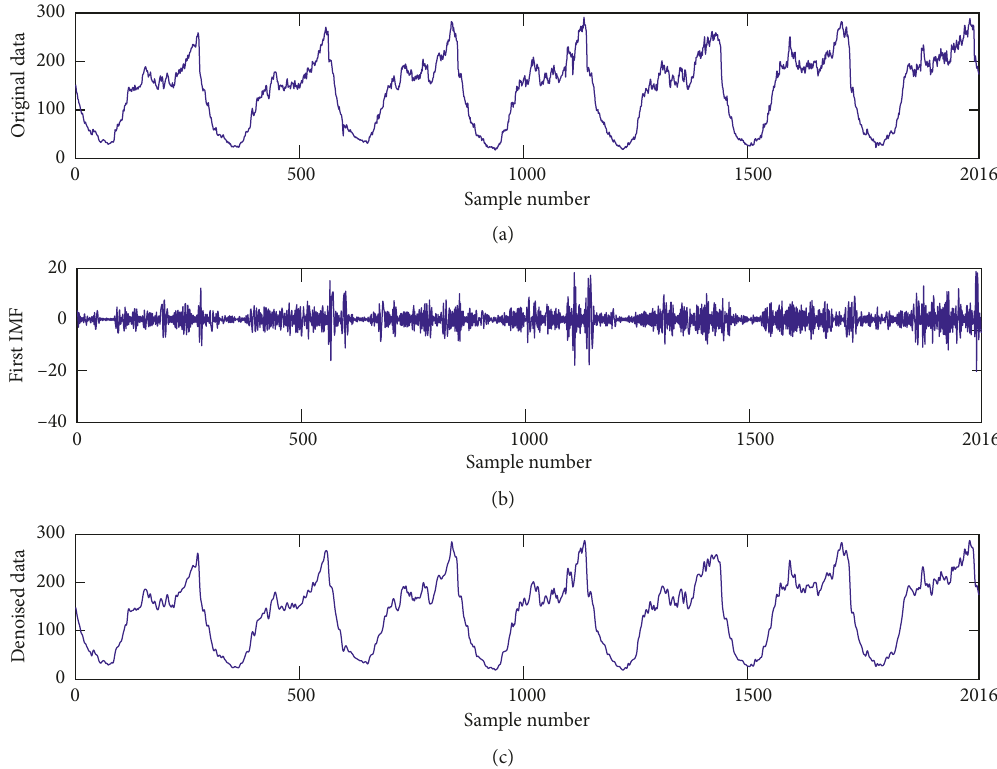
Figure 5: The noise eliminating process of inflow data.